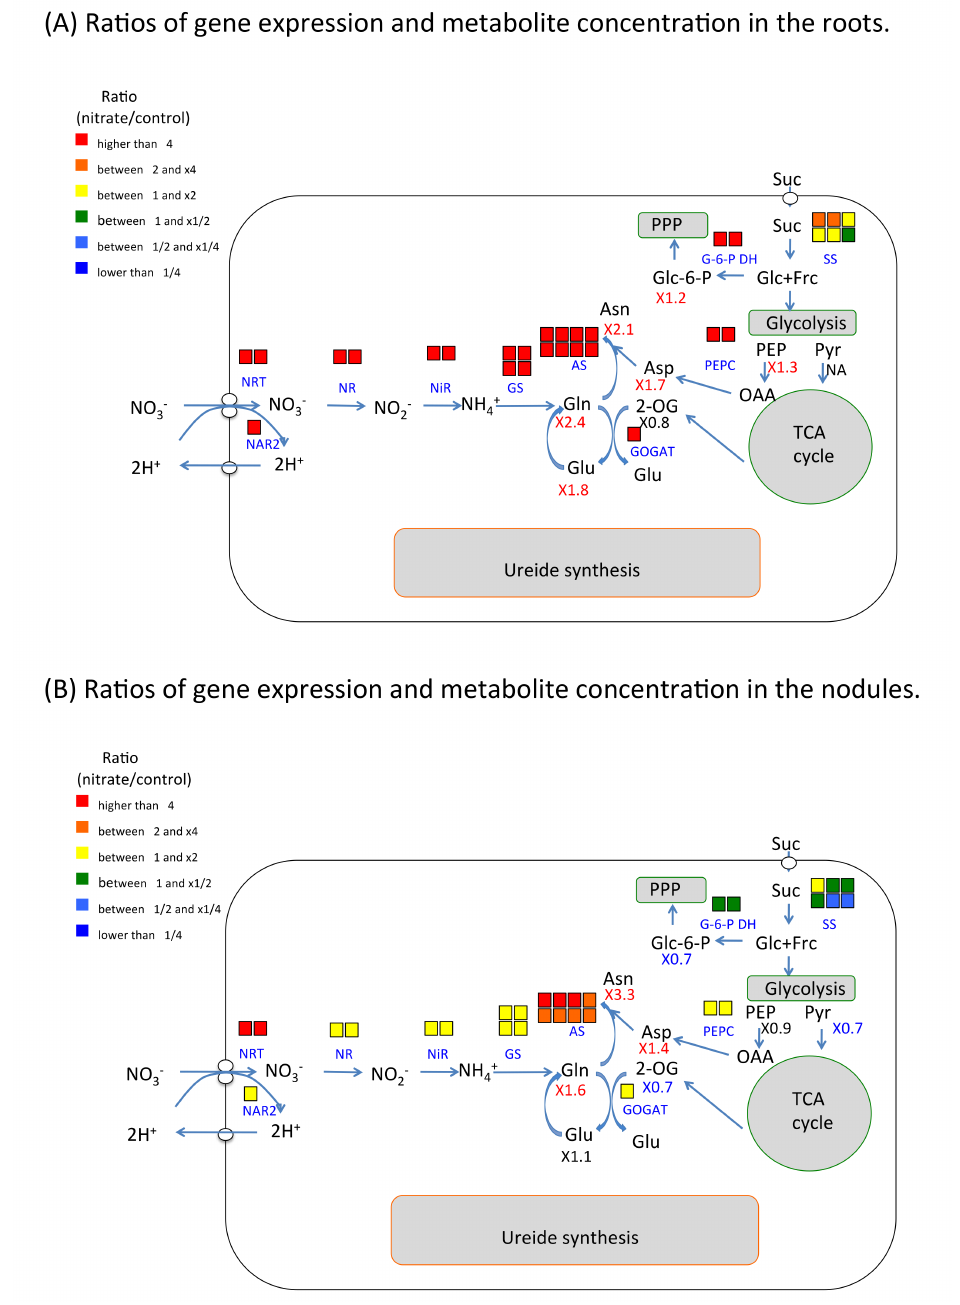
Figure 3. Ratios of gene expression and metabolites related to primary nitrogen assimilation and related carbon metabolism in soybean roots and nodules after 24 h of the 5-mM nitrate treatment. ( A ) Ratios of gene expression and metabolite concentration in the roots. ( B ) Ratios of gene expression and metabolite concentration in the